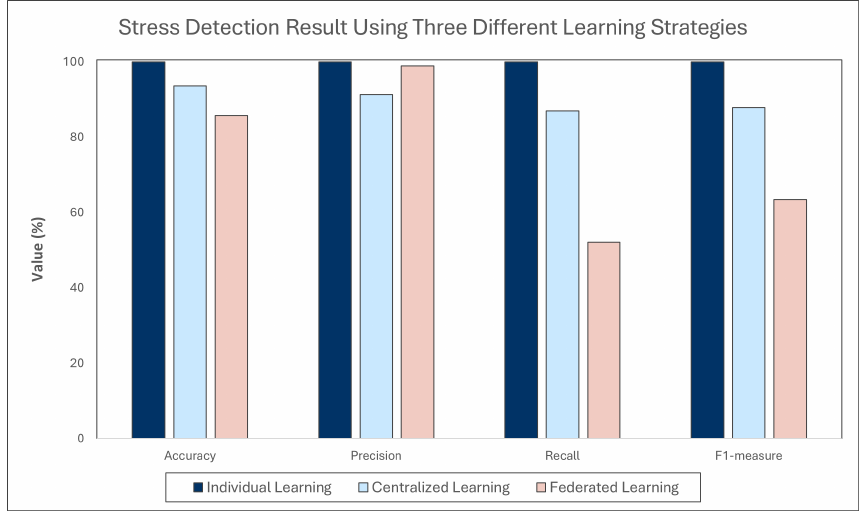
Figure 5. Stress Detection Results Using Three Different Learning